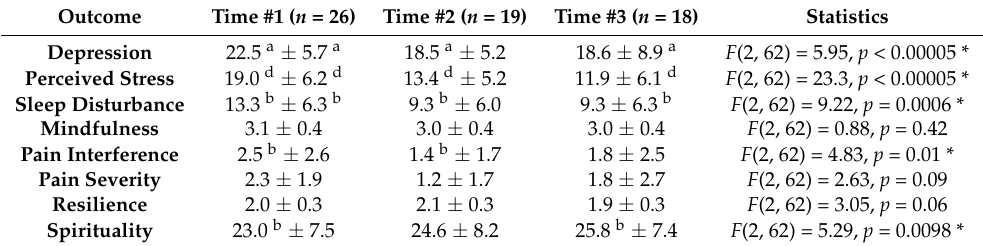
Table 4. Outcomes for IMMI only participants Time #1, Time #2, Time